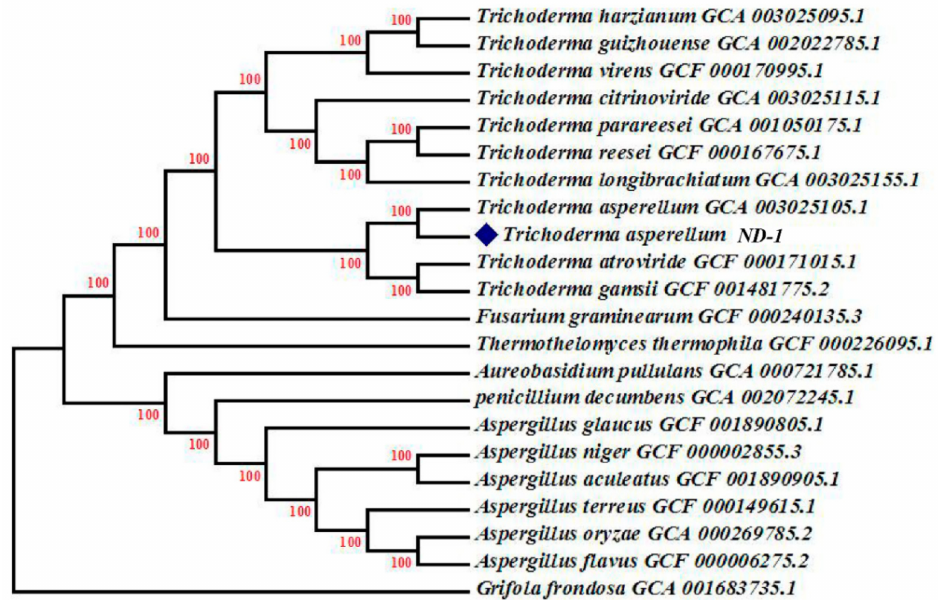
Figure 4. Whole-genome phylogenetic analysis of T. asperellum ND-1 sequences. The tree of selected genome sequences was constructed by using the neighbor-joining (NJ) method with the Poisson model, as implemented in Mega software 7.0. T. asperellum ND-1 was labeled with diamonds. Comparative analysis of orthologous genes between different Trichoderma